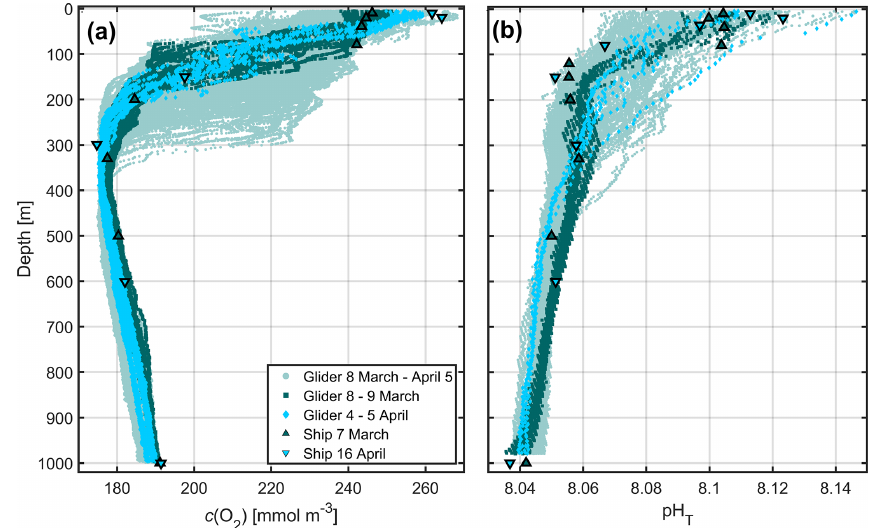
Figure 2. Calibrated glider (a) c( O 2 ) and (b) ISFET pH T over the whole deployment (pale green), 8–9 March (dark green) and 4–5 April (light blue). Ship samples were collected on 7 March (dark green upward-pointing triangles) and on 16 April (light blue downward-pointing triangles).